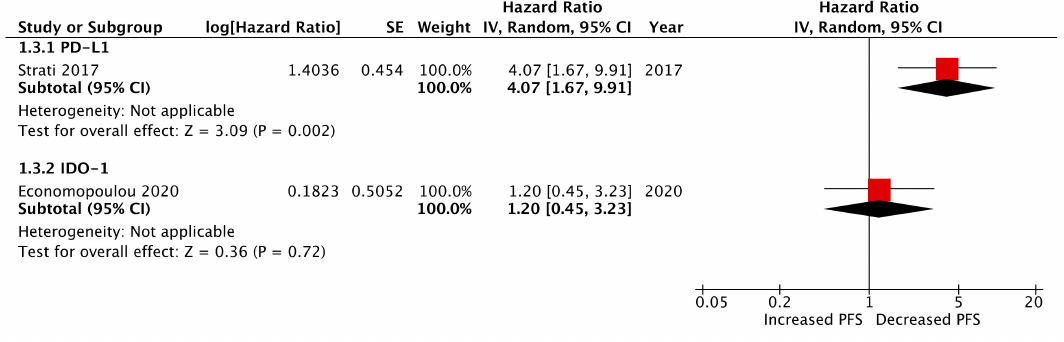
Figure 4. Forest plot of post-treatment CTC immune-marker expression as a biomarker of progression-free survival (PFS) (presented data may vary from Table 2 due to conversion